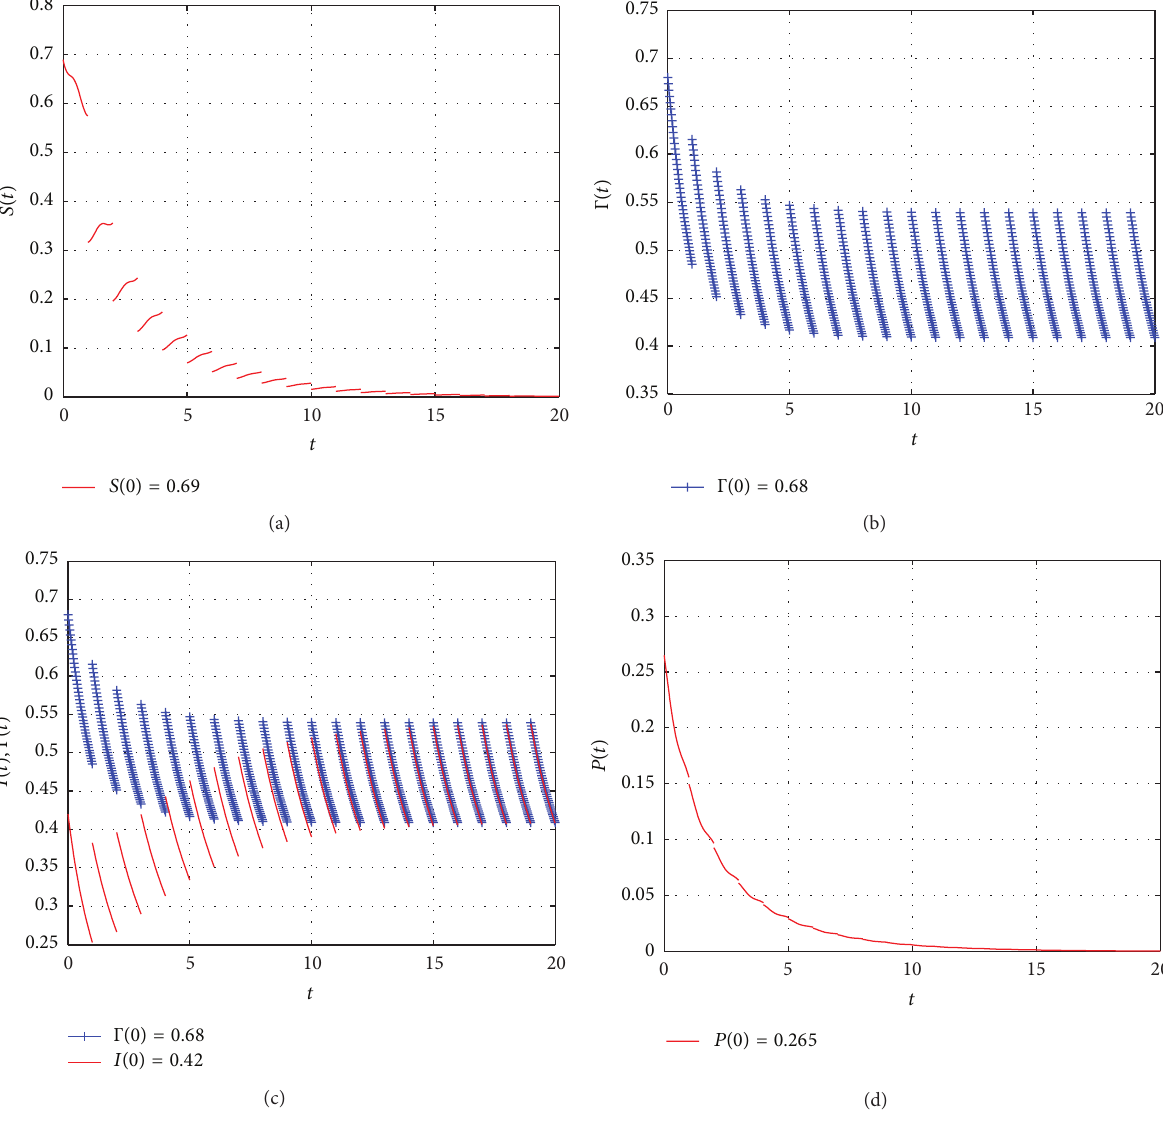
Figure 4: Partial extinction of system (80) with 𝛼 𝑘 = −0.45 , 𝑝 = 0.13 , and 𝛾 𝑘 = −0.04 . (a) Time series of 𝑆 for 𝑡 ∈ [0,20] . (b) Time series of Γ for 𝑡 ∈ [0, 20] . (c) Time series of Γ and 𝐼 for 𝑡 ∈ [0,20] . (d) Time series of 𝑃 for 𝑡 ∈ [0, 20]